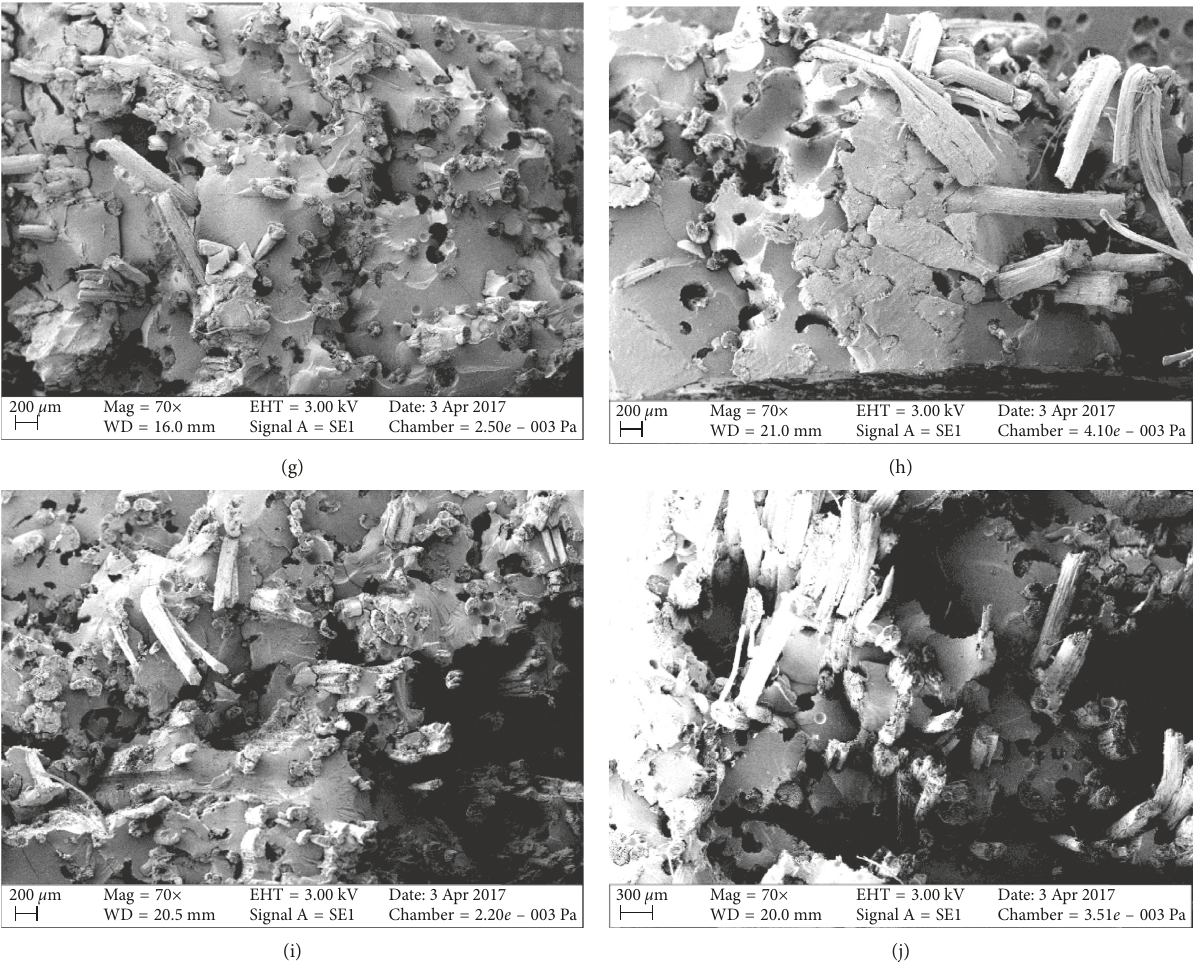
Figure 4: Impact scans of epoxy resin and untreated and treated sisal fibre-epoxy resin composites. (a) 5 wt.% untreated sisal fibre-epoxy resin reinforced composite. (b) 5 wt.% treated sisal fibre-epoxy resin reinforced composite.(c) 10 wt.% untreated sisal fibre-epoxy resin reinforced composite. (d) 10 wt.% treated sisal fibre-epoxy resin reinforced composite. (e) 15 wt.% untreated sisal fibre-epoxy resin reinforced composite. (f) 15 wt.% treated sisal fibre-epoxy resin reinforced composite. (g) 30 wt.% untreated sisal fibre-epoxy resin reinforced composite. (h) 30 wt.% treated sisal fibre-epoxy resin reinforced composite. (i) 50 wt.% untreated sisal fibre-epoxy resin reinforced composite. (j) 50 wt.% treated sisal fibre-epoxy resin reinforced composite.